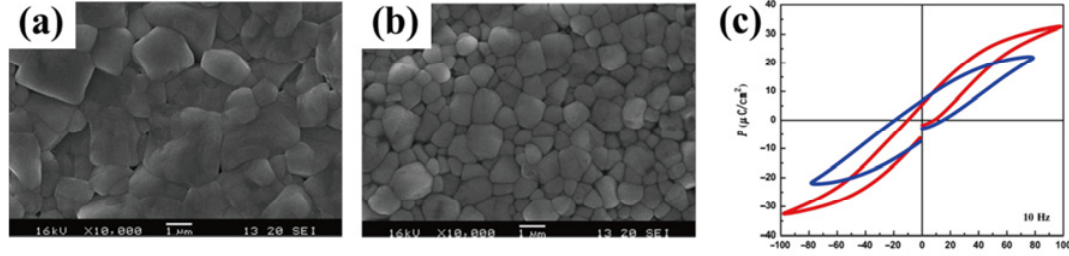
Fig. 19 SEM images of BNT–BT–KNN ceramics sintered via (a) one-step sintering and (b) two-step sintering. (c) P – E loops of different sintering methods. Reproduced with permission from Ref. [74], © Elsevier B.V.